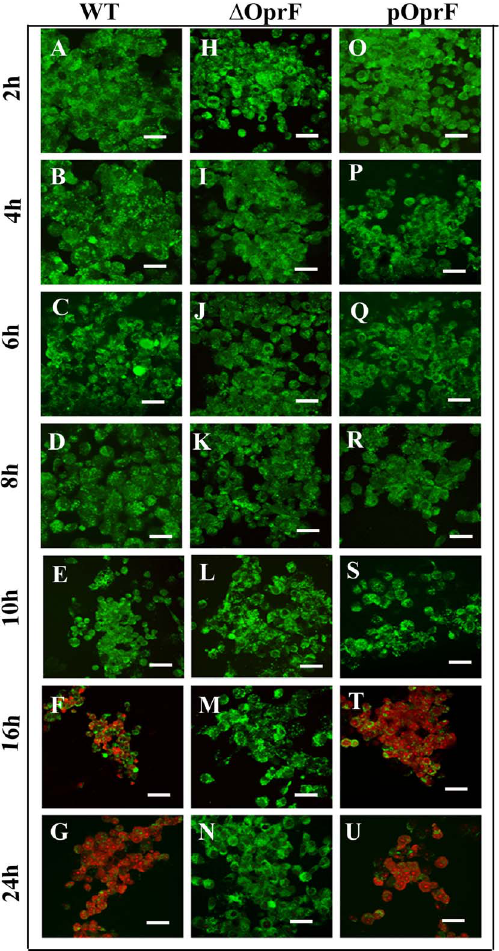
Figure 8. P.aeruginosa causes epithelial cell damage. HMEECs were infected with P. aeruginosa at an MOI of 10 for varying time periods. Cell damage was examined using the LIVE/DEAD fluorescent assay where uptake of green dye indicates live cells and red staining corresponds to dead cells. Results are representative of four indepen- dent experiments carried out in triplicate. Scale bars 10 m m.